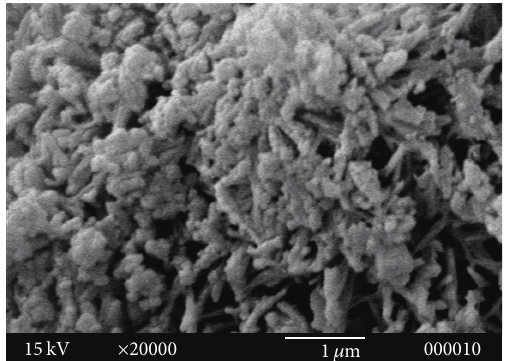
F 7: e SEM micrograph of sewage sludge ash blended cement paste (S4) hydrated for 28 days.